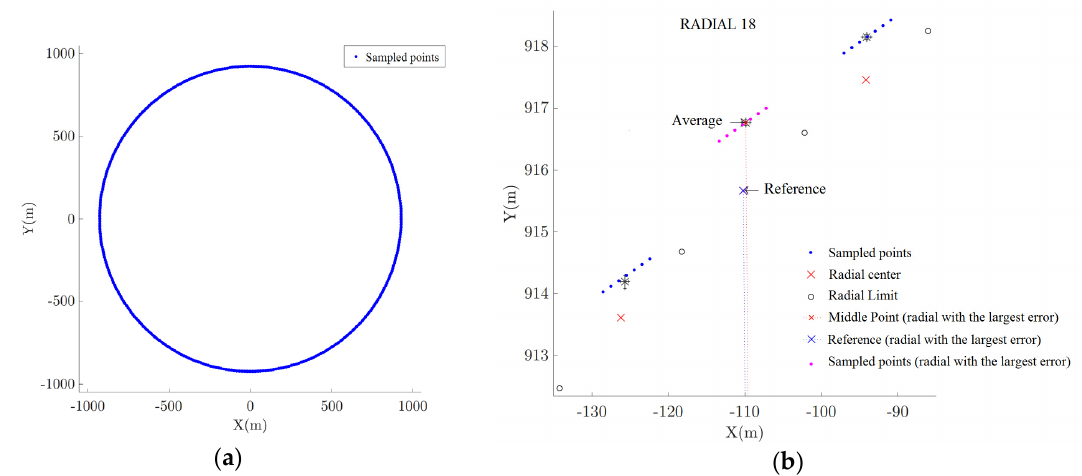
Figure 10. Mission flight using the HIL platform: ( a ) Inspection trajectory in Test 1 ; ( b ) Radial with the largest error in Test 1 .